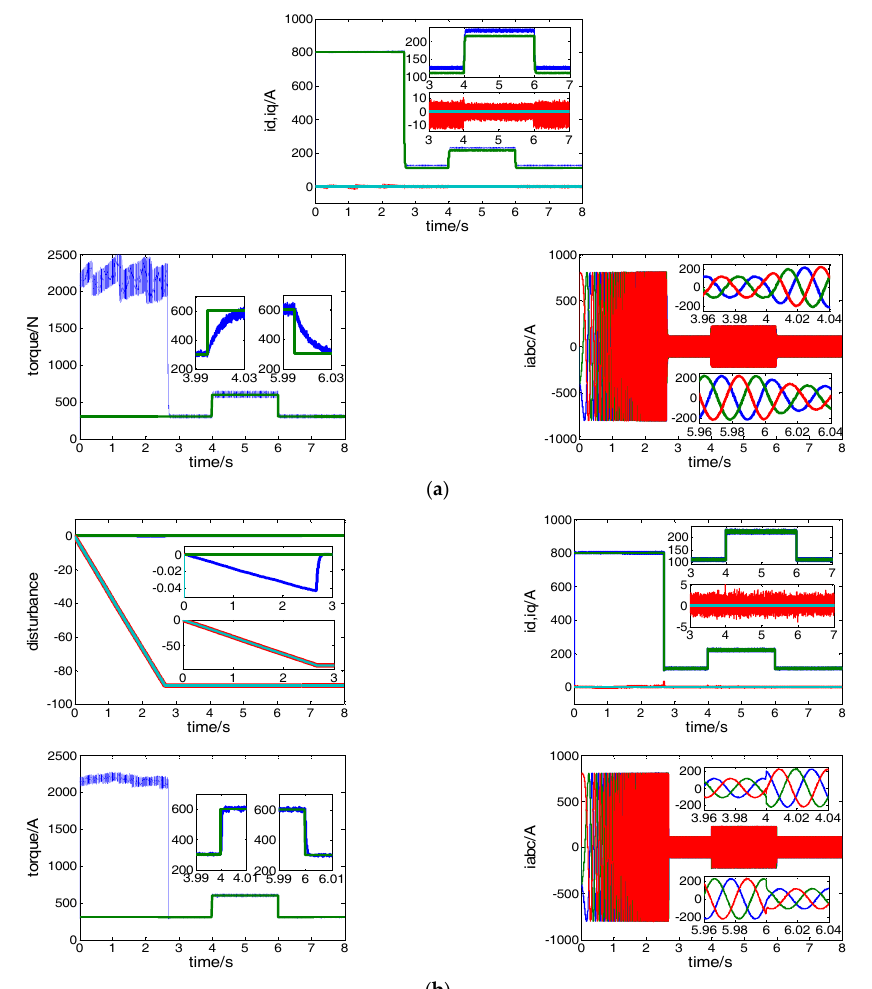
Figure 10. Simulation comparisons of the two controllers against permanent magnet demagnetization = − 50% ψ ro ) : ( a ) Conventional PCC and ( b ) proposed ( ∆ ψ rd